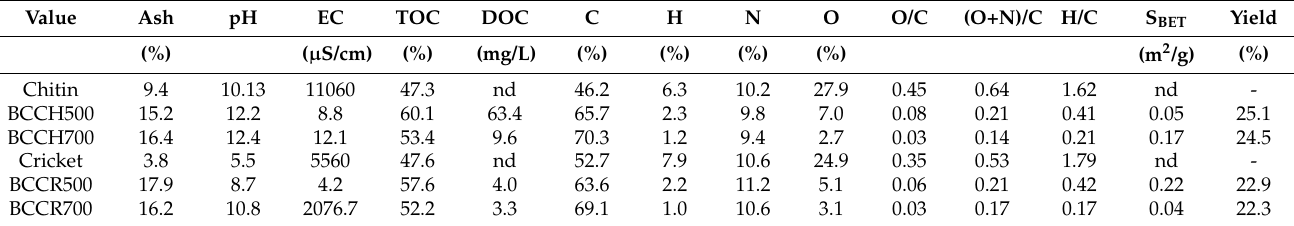
Table 2. The physicochemical properties of feedstock and derived